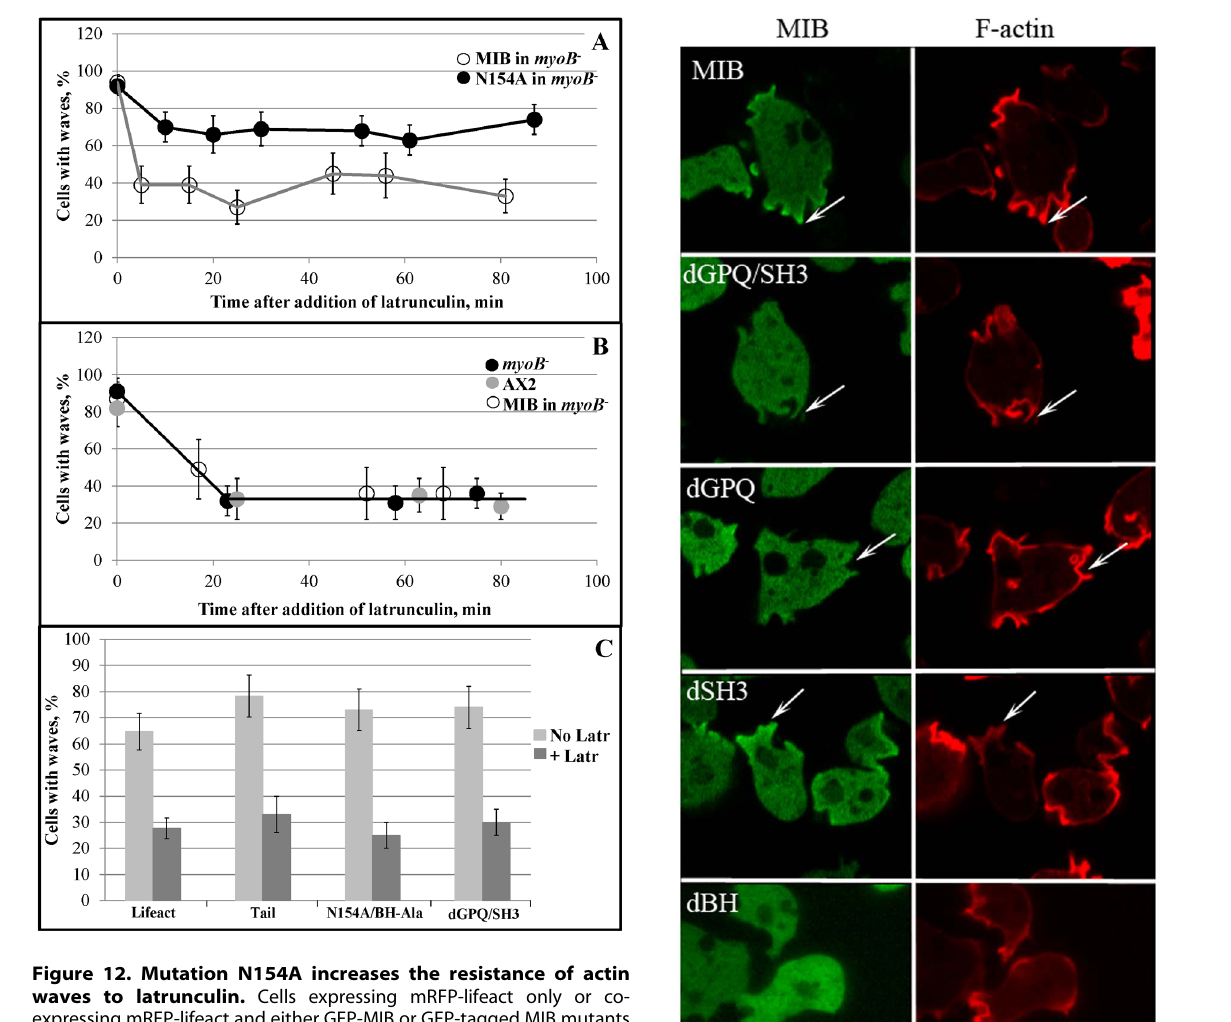
head actin affinity and, therefore, enhanced actin crosslinking ability, associates more strongly with waves than WT-MIB and stabilizes waves against disassembly by latrunculin. This most likely reflects actin crosslinking by WT-MIB. Also, the N154A mutation